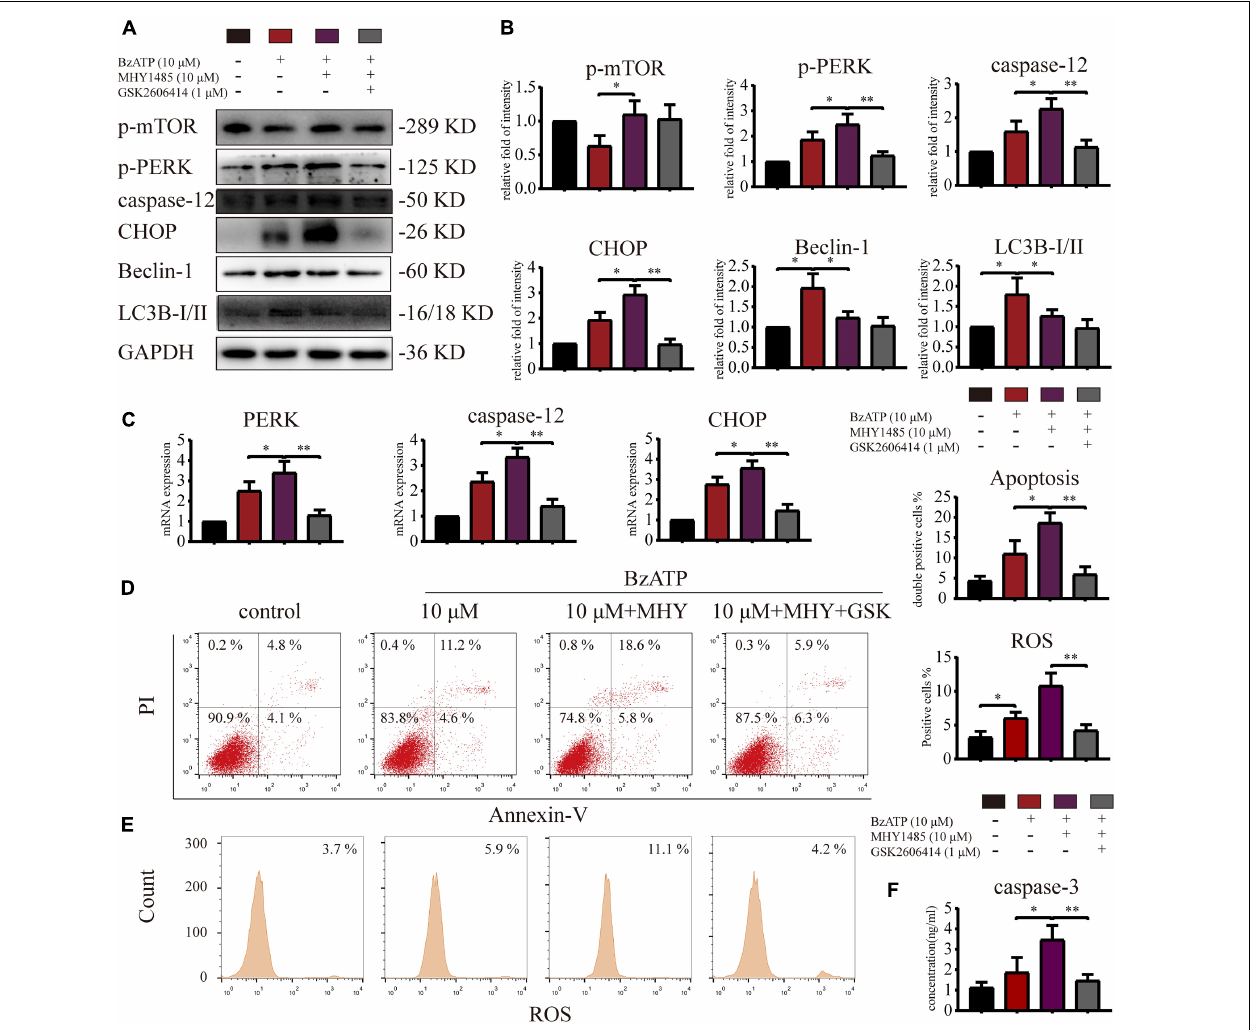
FIGURE 6 | mTOR inhibits autophagy and promotes ER stress-apoptosis through PERK. Cells were cultured with 10 µ M Bz-ATP, 1 µ M GSK2606414 (GSK), with or without 10 µ M MHY1485 (MHY). Western blotting (A,B) and qRT-PCR (C) were used to detect the protein and mRNA expression levels of mTOR, PERK , caspase-12 , CHOP , LC3B, and Beclin-1. Flow cytometry was used to detect the percentage of Annexin-V/PI double-stained cells (D) and the level of intracellular oxidative stress ROS (E) . (F) The caspase-3 activity assay; the statistical results are homogenized. Data are expressed as means ± standard deviations of at least three independent experiments. ∗ p < 0.05, ∗∗ p <